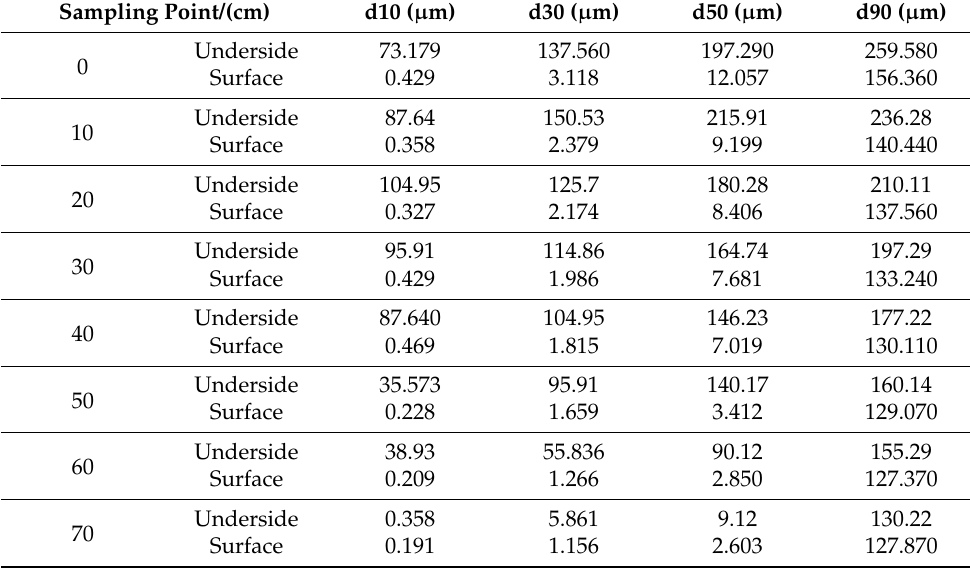
Table 3. The sixth layer particle size distribution.